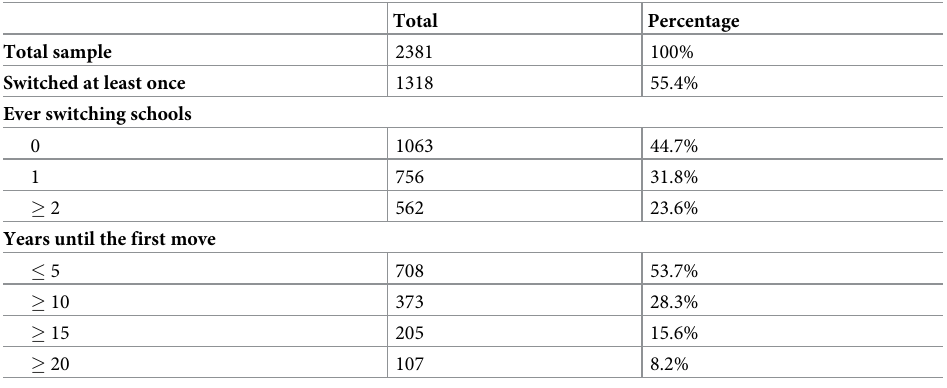
Table 1. Description of teacher mobility